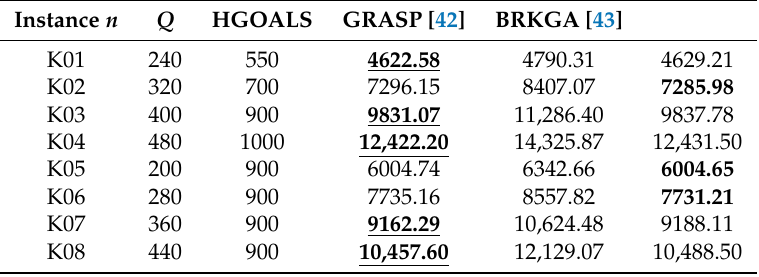
Table 9. Comparison between the HGOALS results and previous research for instances in group K (minimizing traveling